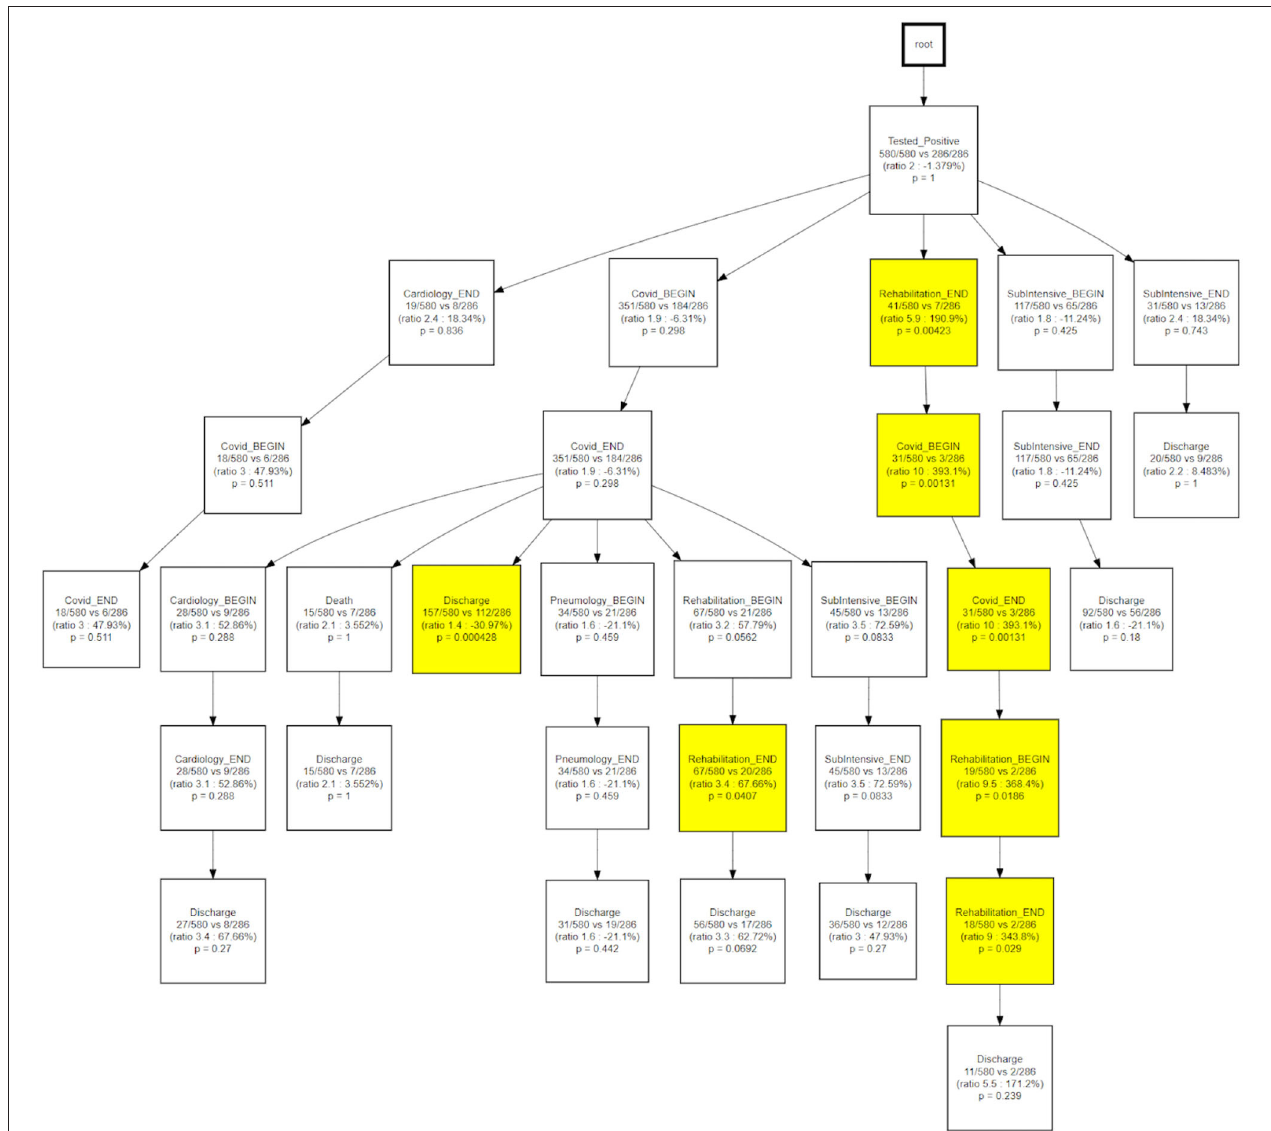
FIGURE 13 | CareFlow miner results - comparison of trajectory 1 with trajectory